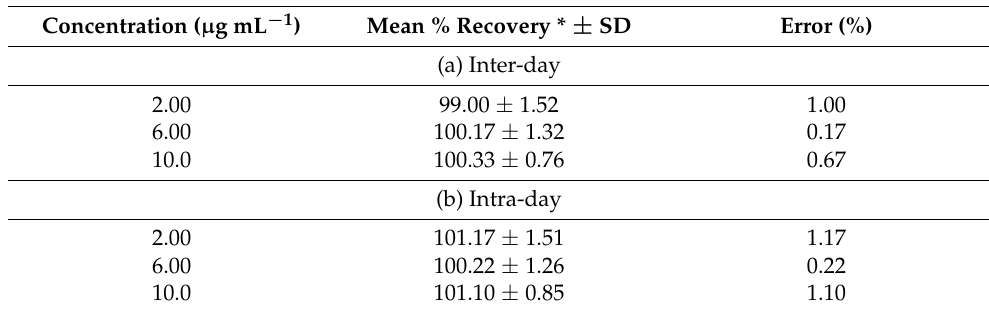
Table 6. Cont. Precision Assays (Inter- and Intra-Day) of TIGC in Tygacil ® Vials